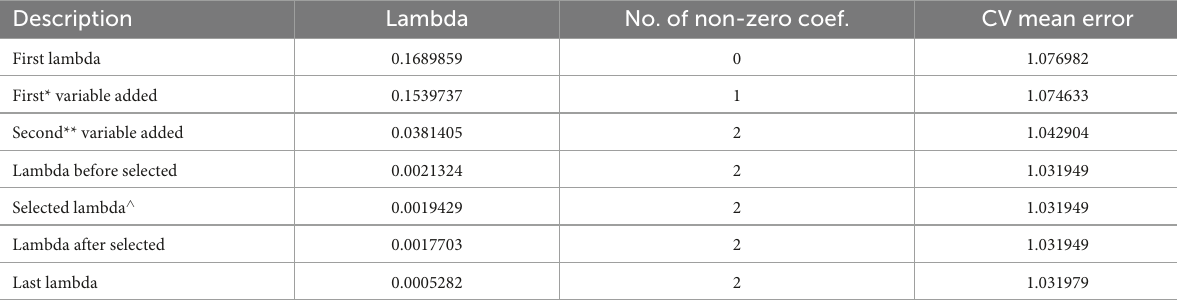
TABLE 2 Results of LASSO regression with adaptive cross-validation.